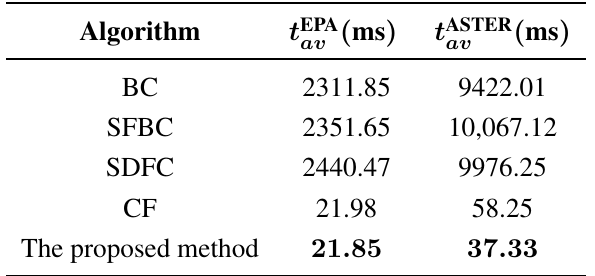
Table 6. Time consumption comparisons of different algorithms with the 2